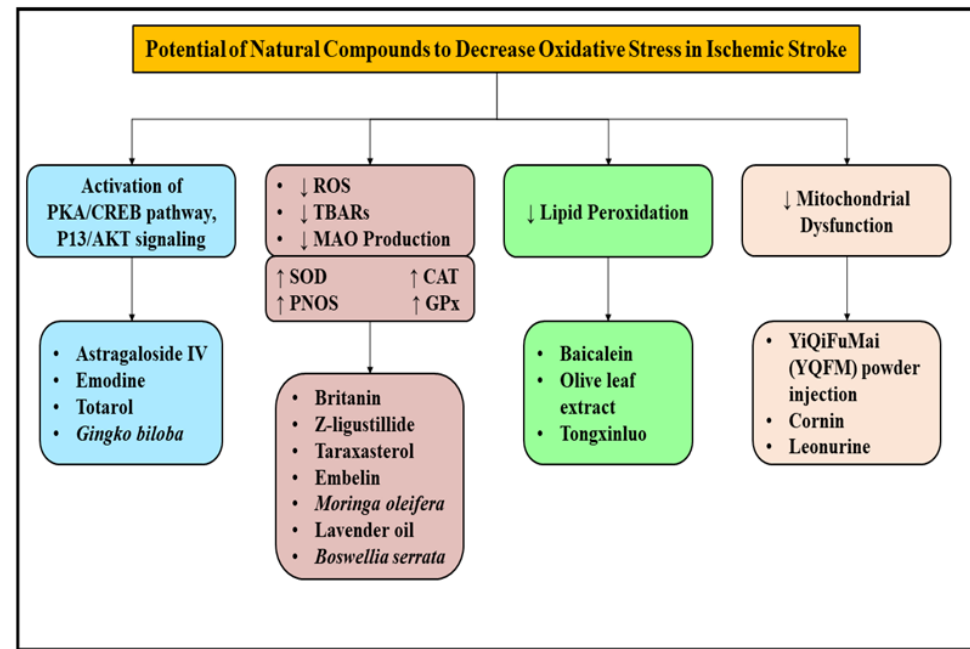
Figure 6. Herbal plants and natural origin bioactive compounds and their mechanisms involved in the management of Ischemic stroke. ROS: Reactive oxygen species; PKA: protein kinase A; CREB: cAMP response element-binding protein; PI3/AKT: phosphatidylinositol 3-kinase/protein kinase B; TBARS: Thiobarbituric acid reactive substances; MAO: Mono amino oxidase; SOD: sodium dismutase; CAT: catalase; GPx: glutathione.